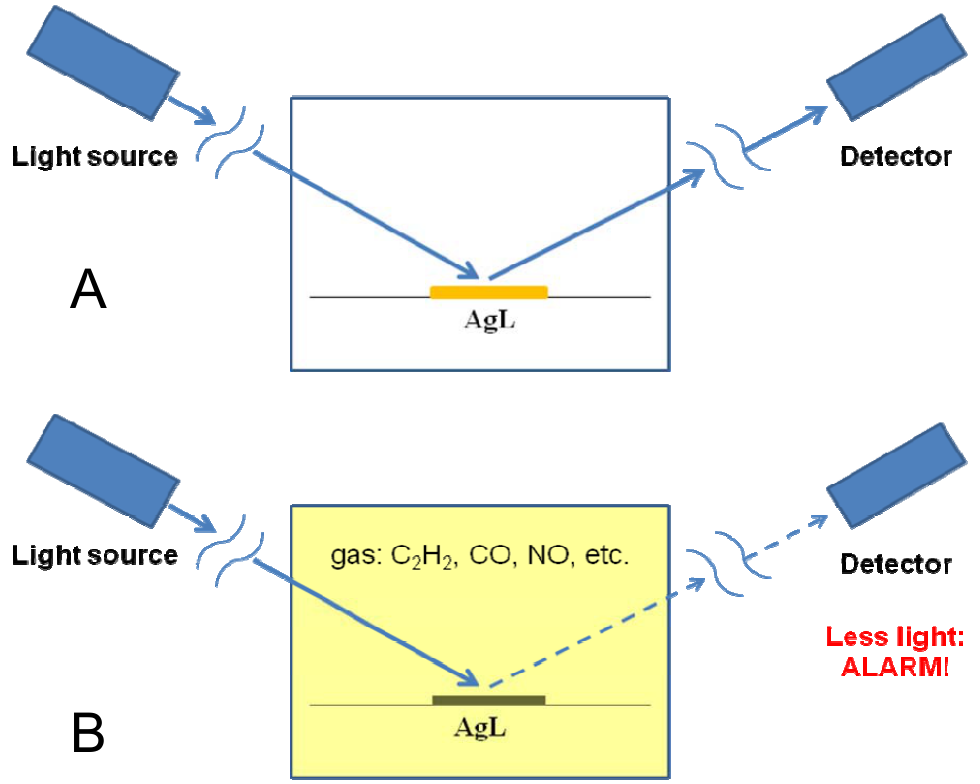
Figure 22. Schematic diagram of the optoelectronic pair working with silver(I) cyanoximates for quantitative detection of gases of industrial importance in closed, illumined premises. The light source could be a remote laser with remote detector measuring the intensity of reflected light from the surface of visible light stable AgL sensor ( A ). When the gas of interest is present, the surface of a sensor gets sensitized and darkens with little light reflected to the detector, which triggers the alarm circuit ( B